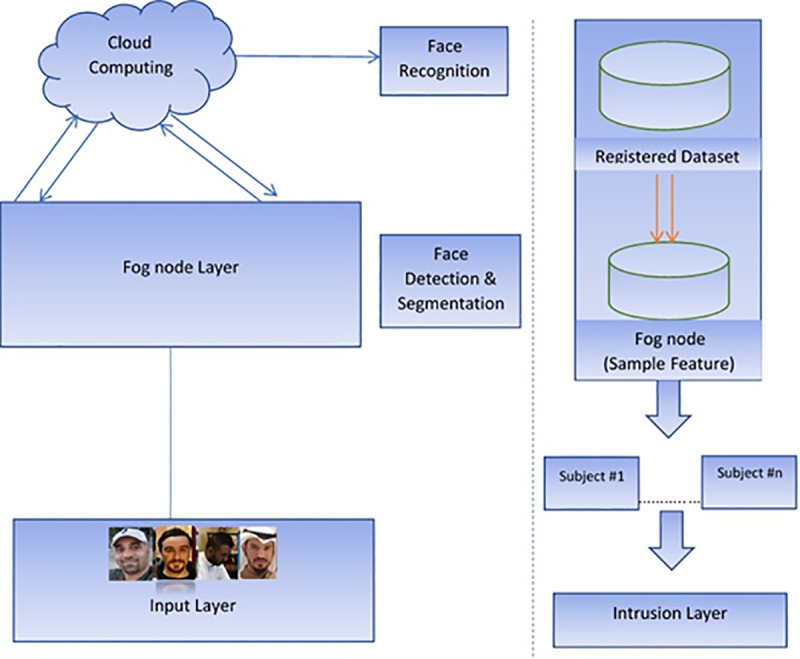
Fog computing network for the face recognition scheme.